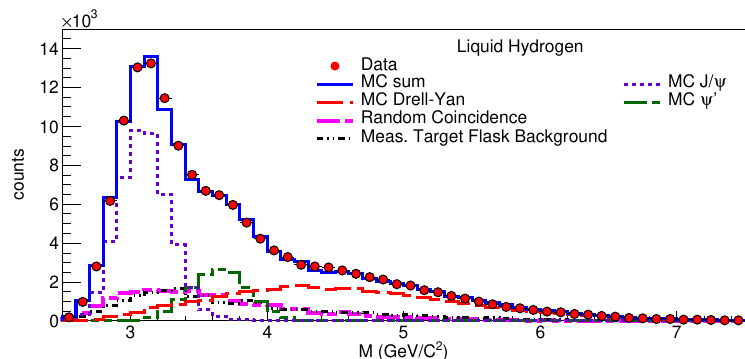
Figure 1: The invariant mass spectrum of reconstructed muon pairs. The data are shown with red points. The distributions of Drell–Yan (red), J /ψ (blue dotted line), and ψ (cid:48) (green) are estimated by Monte Carlo simulation. The random background (magenta) is estimated with experimental data by event mixing method. The black line shows the target flask background. The blue line is the fit of the experimental data with those components.